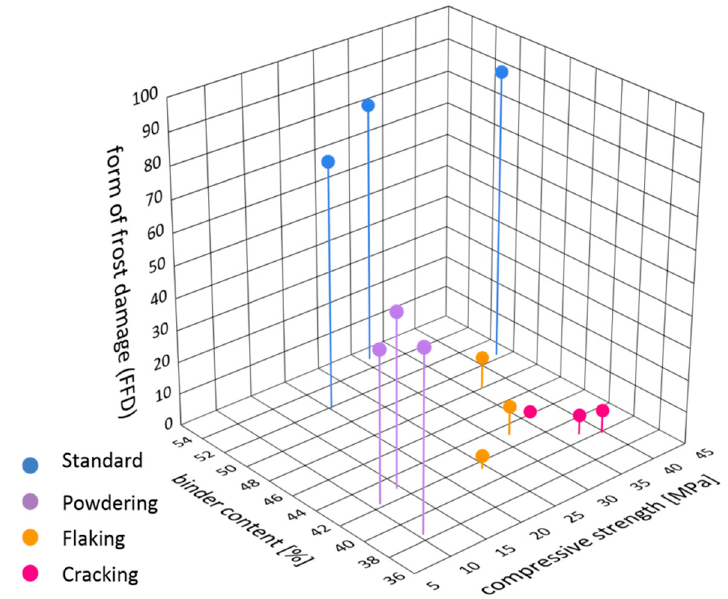
Figure 13. Quantitative correlation between compressive strength, binder content and form of frost damage (FFD) factor.